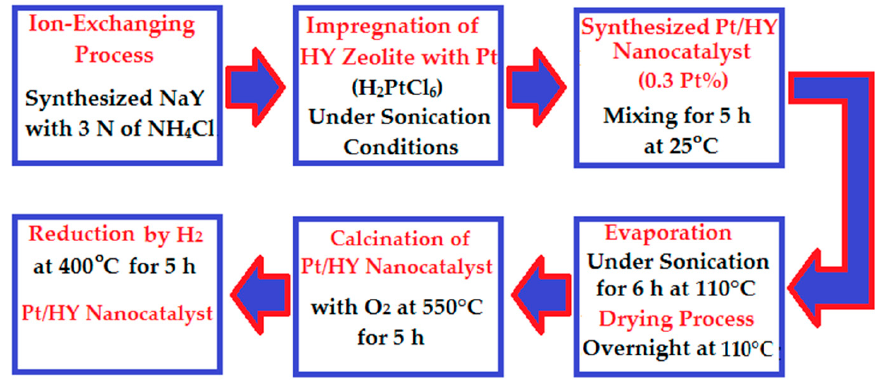
Figure 1. Main stages of the Pt/HY nanocatalyst preparation.